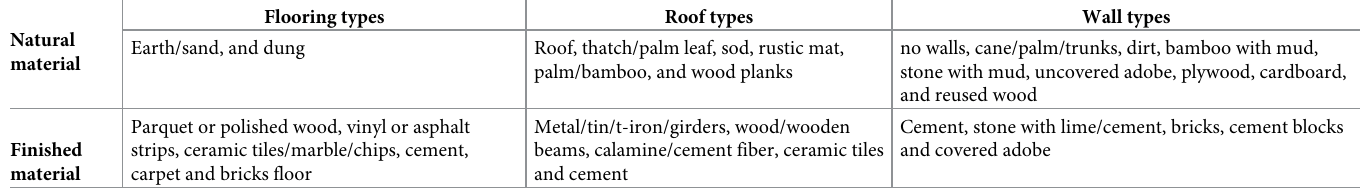
Table 2. Categorisation of finished and natural housing